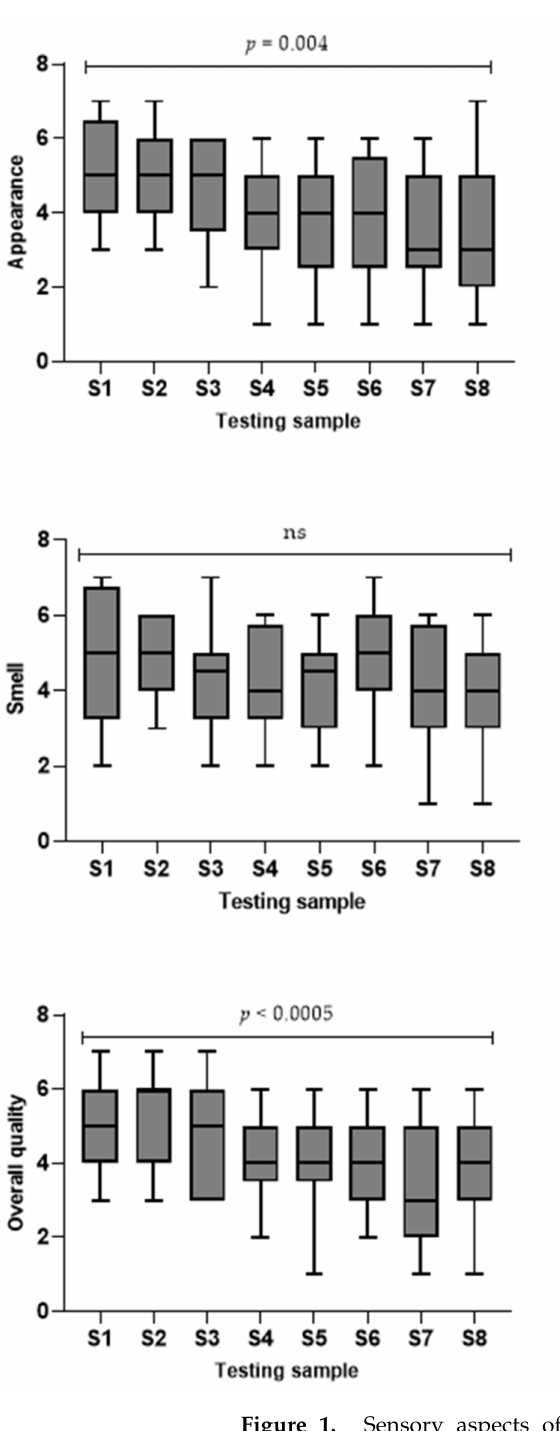
Figure 1. Sensory aspects of texture-modified meal testing samples using a 7-point scale. 1 = extremely poor, 4 = average, 7 = excellent. S1 = freshly made Soft & Bite-Sized sample, S2 = sous-vide Soft & Bite-Sized sample, S3 = freshly made Minced & Moist sample, S4 = hy- drolysed Minced & Moist sample, S5 = commercially packaged Minced & Moist sample, S6 = freshly made pureed sample, S7 = hydrolysed pureed sample and S8 = commercially packaged pureed sample. Kruskal-Wallis test was performed. ns = no significance. p < 0.05 indicates